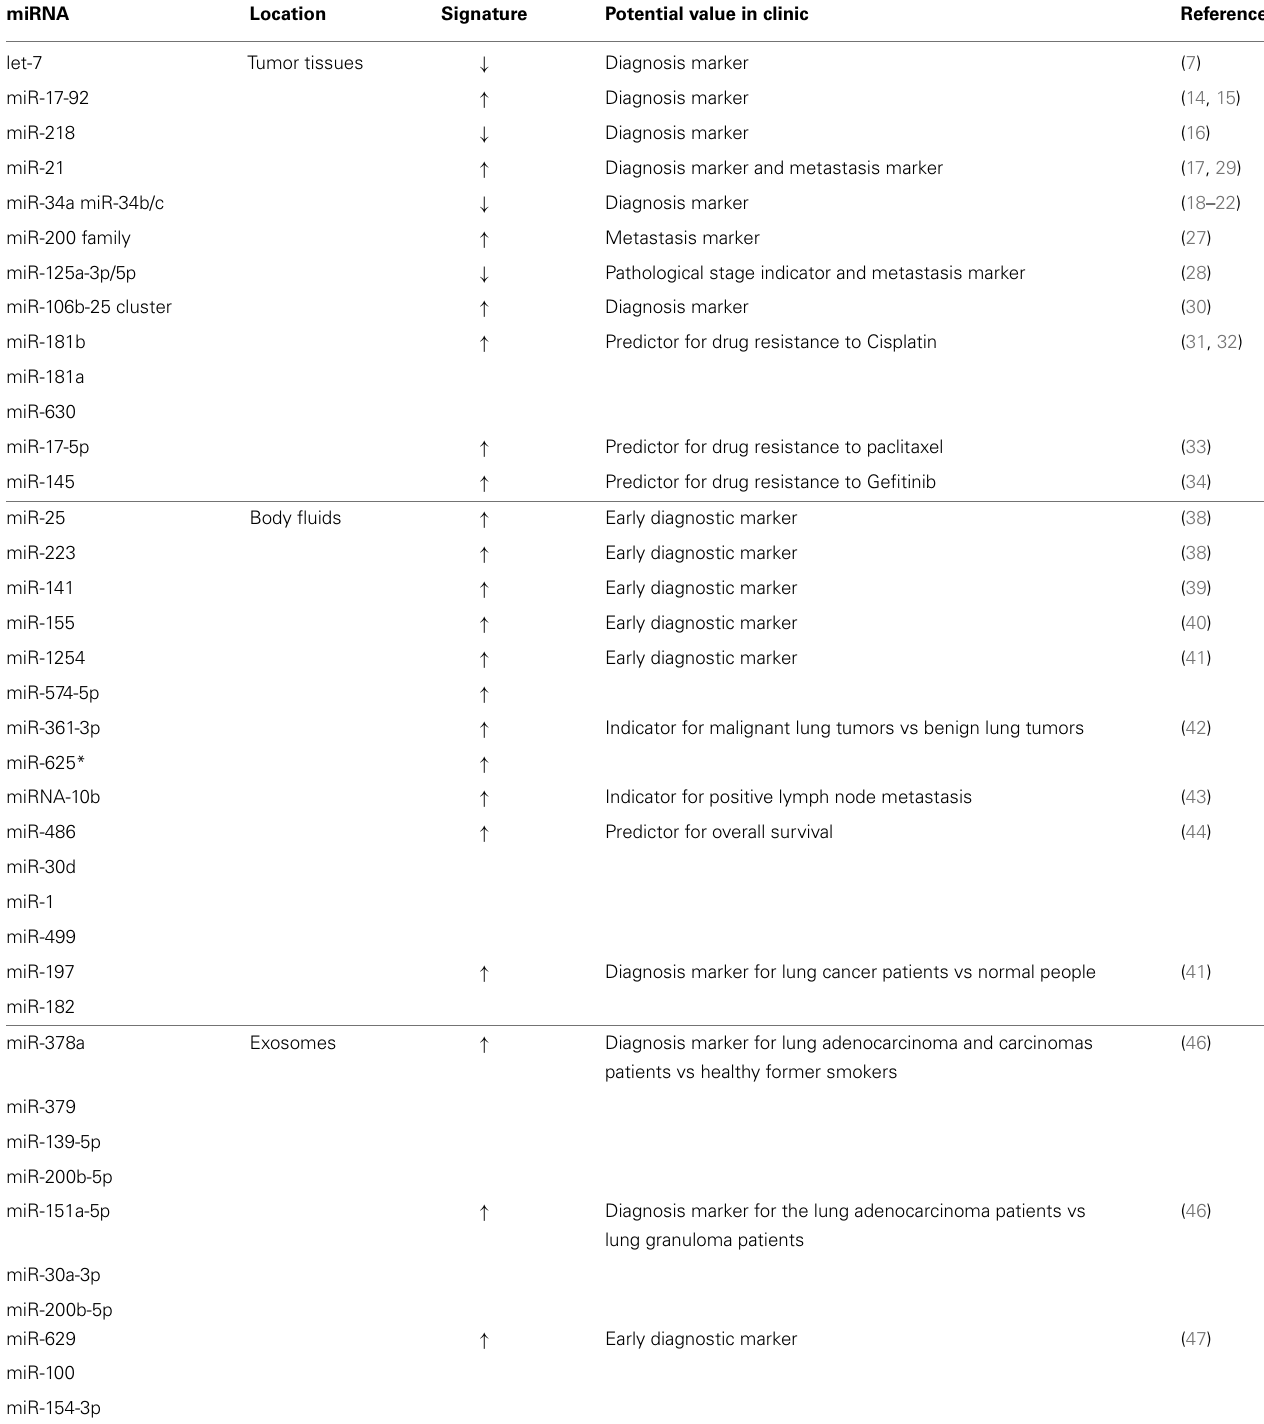
Table 1 | Selected microRNA signatures in lung cancer and their potential value in clinic .